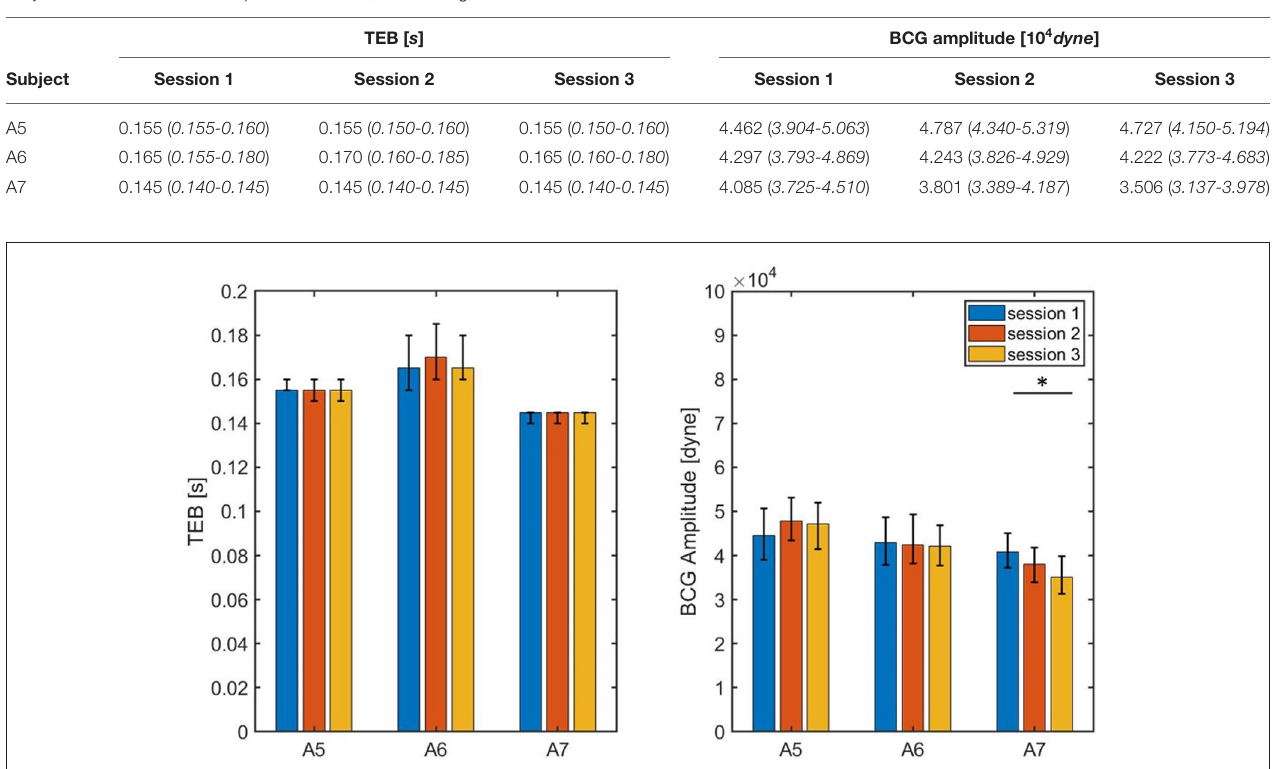
Frontiers in Medical Technology |